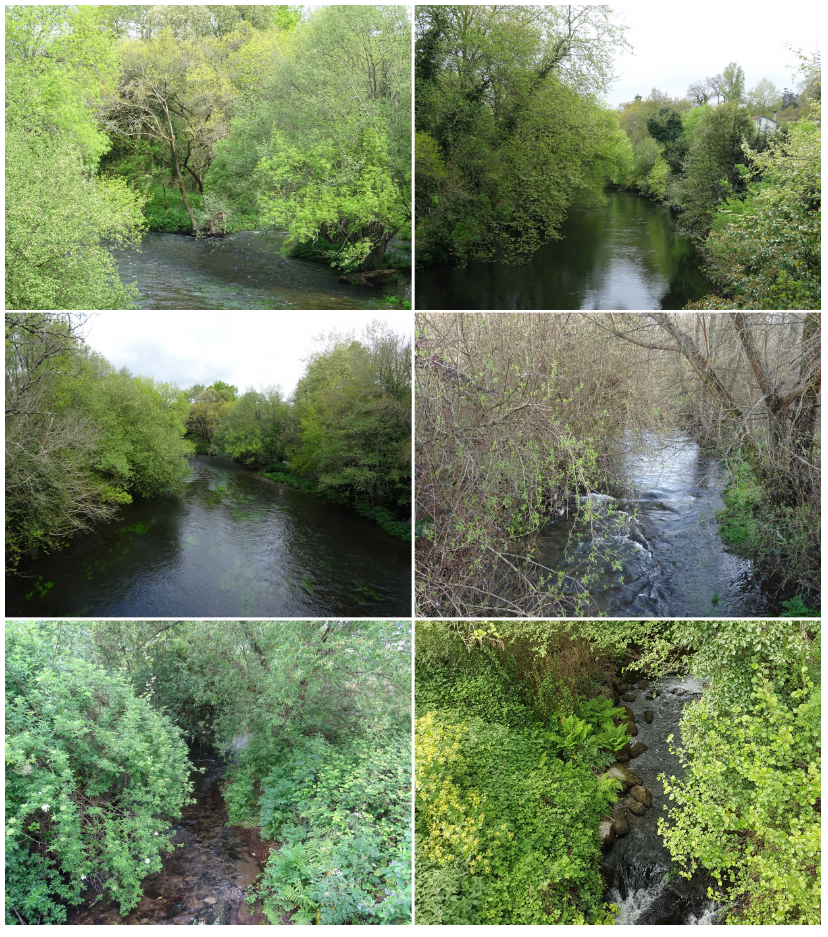
Figure 1. Photographs of rivers and riparian vegetation in Galicia, Spain, taken in spring 2021.